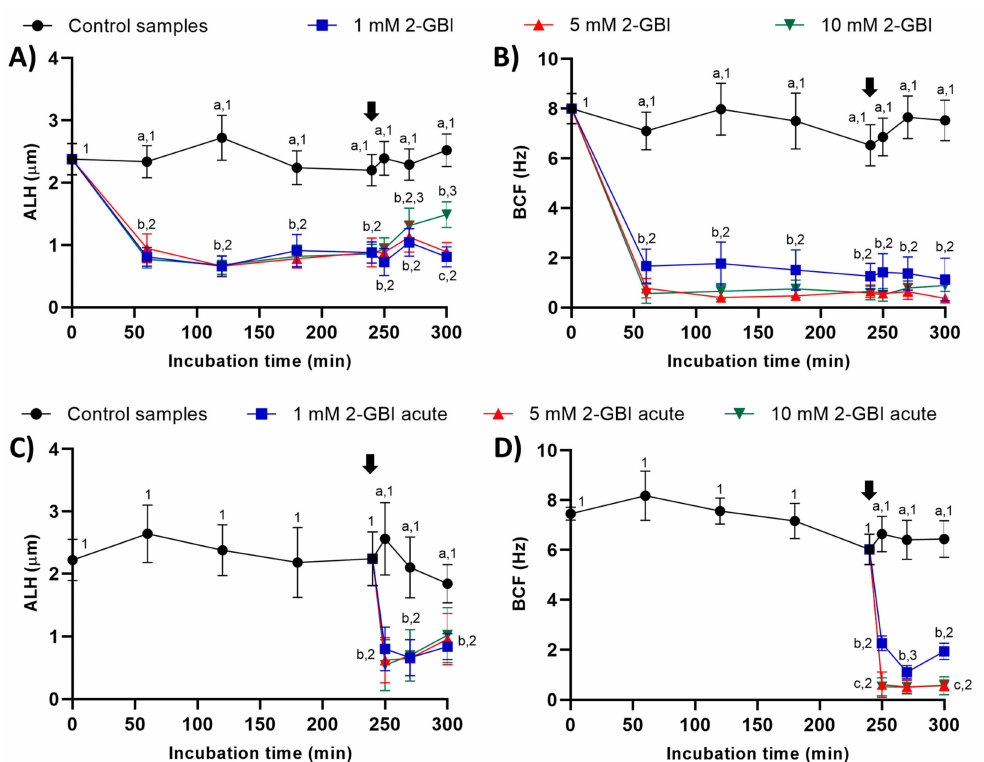
Figure 5. Amplitude of lateral head displacement (ALH) and beat cross frequency (BCF) throughout the incubation of sperm in capacitating medium (control samples) and capacitating medium plus 1 mM, 5 mM or 10 mM 2-GBI. The blocker was added to capacitating medium either at 0 min in experiment 1 ( A – C ) or after 240 min of incubation in experiment 2 ( D – F ; acute). Di ff erent superscript letters (a–c) indicate significant di ff erences ( p < 0.05) between samples within the same time point, and di ff erent superscript numbers (1–3) indicate significant di ff erences ( p < 0.05) between time points within a given treatment. Results are expressed as mean ± SEM ( n = 10). The arrow indicates the time at which 10 µ g / mL of progesterone was added to all samples (i.e., 240 min of